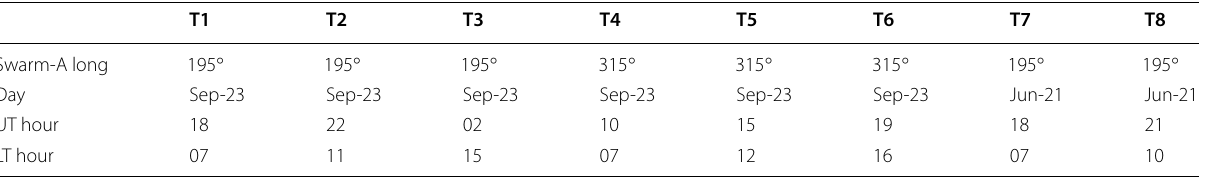
Orbit of Swarm-C is 5 ◦ eastward of Swarm-A. Orbital altitude is 442 km and inclination is assumed to be 90 ◦